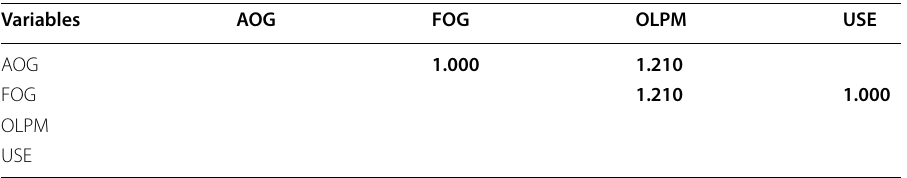
The bolded values in Table 4 are the VIF values that were all below the 3.0 threshold